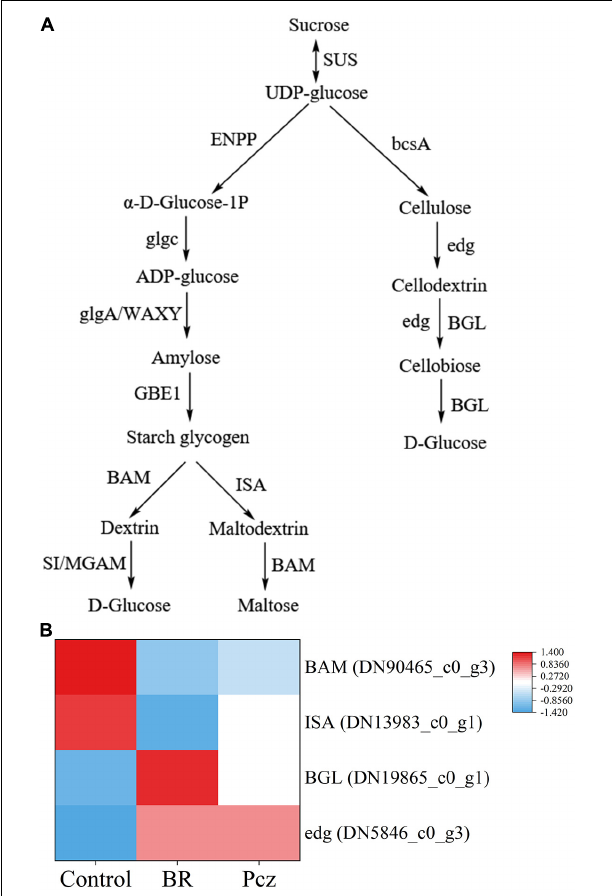
FIGURE 3 | Analysis of differentially expressed genes related to starch and sucrose metabolism in bulbil of P. ternata under BR and Pcz treatments. (A) The starch and sucrose metabolism. (B) The expression levels of genes related to the starch and sucrose metabolism. Blue indicates a lower expression level, whereas red indicates a higher expression level. All data showed the average mean of three biological